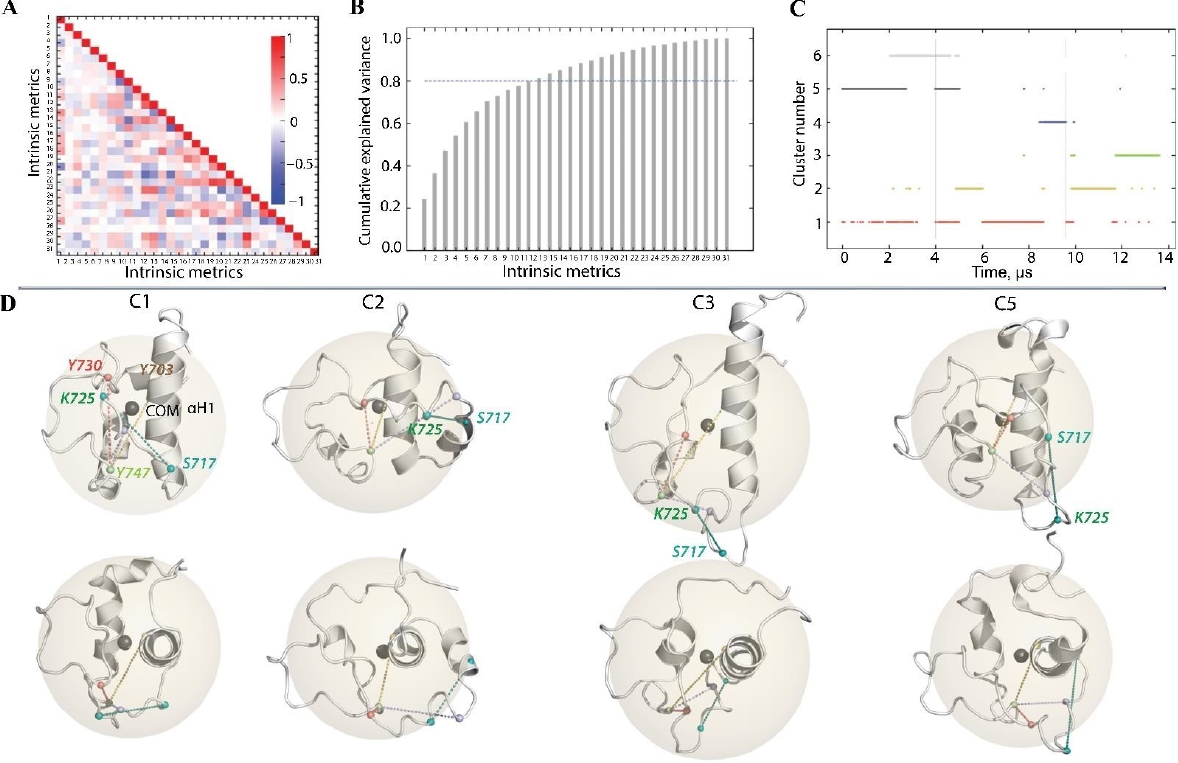
Figure 7. Clustering of KID conformations was performed on the concatenated 14 µ s trajectory. ( A ) A correlation matrix showing correlation coefficients between 31 features. The features are (1) Rg, (2) number of hydrophobic contacts, (3) number of H-bonds, (4–7) SASA for each tyrosine residue, (8–15) backbone dihedral angles φ and ψ , (16–21) distances between the tyrosine residues, (22) tyrosine tetrahedron volume, (23–25) distances between the maximally fluctuating residues, (26–28) dihedral angle between the maximally fluctuating residues, (29) triangle area between the maximally fluctuating residues, (30) distance between the minimally fluctuating residues, (31) dihedral angle between the minimally fluctuating residues. ( B ) PCA analysis performed on the pre-processed data. ( C ) Clusters obtained from the concatenated 14 µ s trajectory and their composition. Each colour represents different cluster. ( D ) The representative conformations from the most populated clusters are shown in three views — side and top — concerning the αH1 -axis. Protein is shown as a cartoon. The sphere corresponds to the gyration radii (Rg). Focusing on features with correlation coefficients (c.c.) ≥ 0.6 or ≤− 0.6, we first ob- served that the S717-K725-R739 triangle area positively correlates to the distance S717- K725 (c.c. of 0.8). The rest of the considered correlation values depend solely on features involving tyrosine residues (pairwise distances and dihedral angles). The size (volume) of the tetrahedron formed by the tyrosine residues is positively correlated with the inter-tyrosine distances Y721-Y730 and Y721-Y747 (c.c. 0.74 and 0.67, respectively). Such dependence is mainly delivered by the spatial mobility of Y721, lo- cated between the highly fluctuating residues S717 and K725, whereas Y730 and Y747 are positioned near the low fluctuating residues V732 and P754, respectively. Other correlated